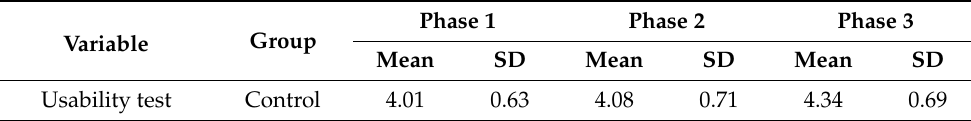
Table 3. Results of repeated measurement analysis of usability test of ANOVA.